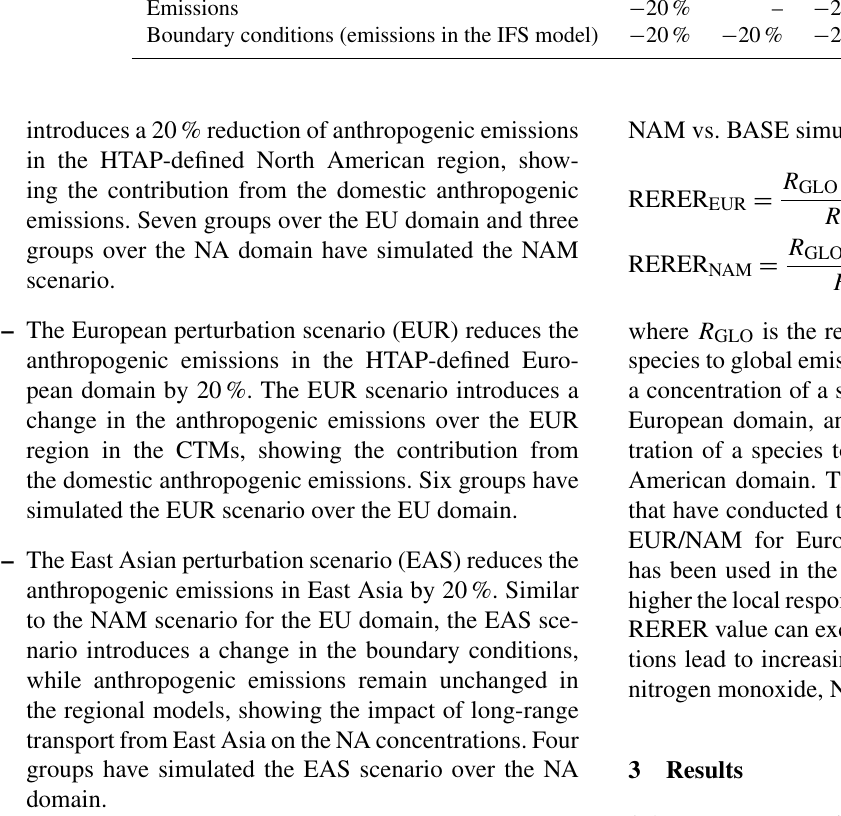
Emissions − 20% – − 20% − 20% – Boundary conditions (emissions in the IFS model) − 20% − 20% − 20% − 20% −